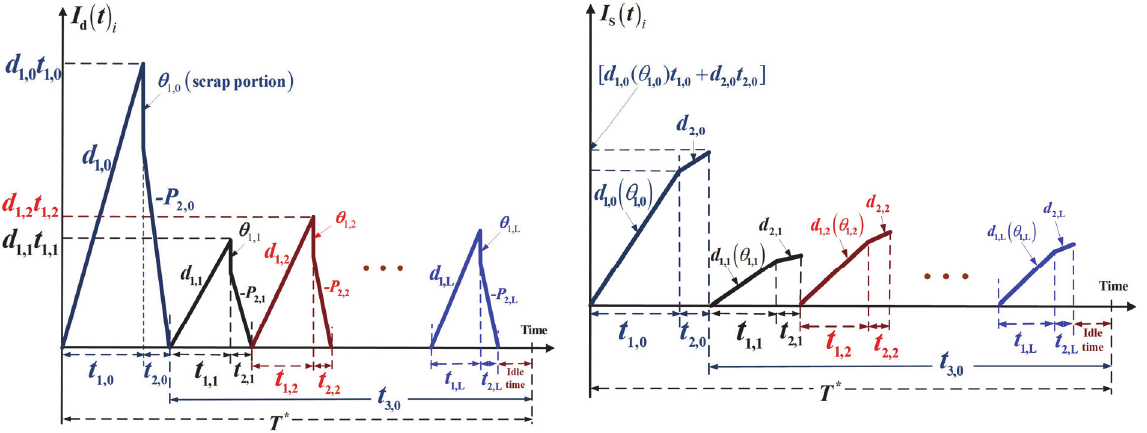
Fig. 2. The inventory status of nonconforming items Fig. 3. The inventory status of scrap items in the proposed